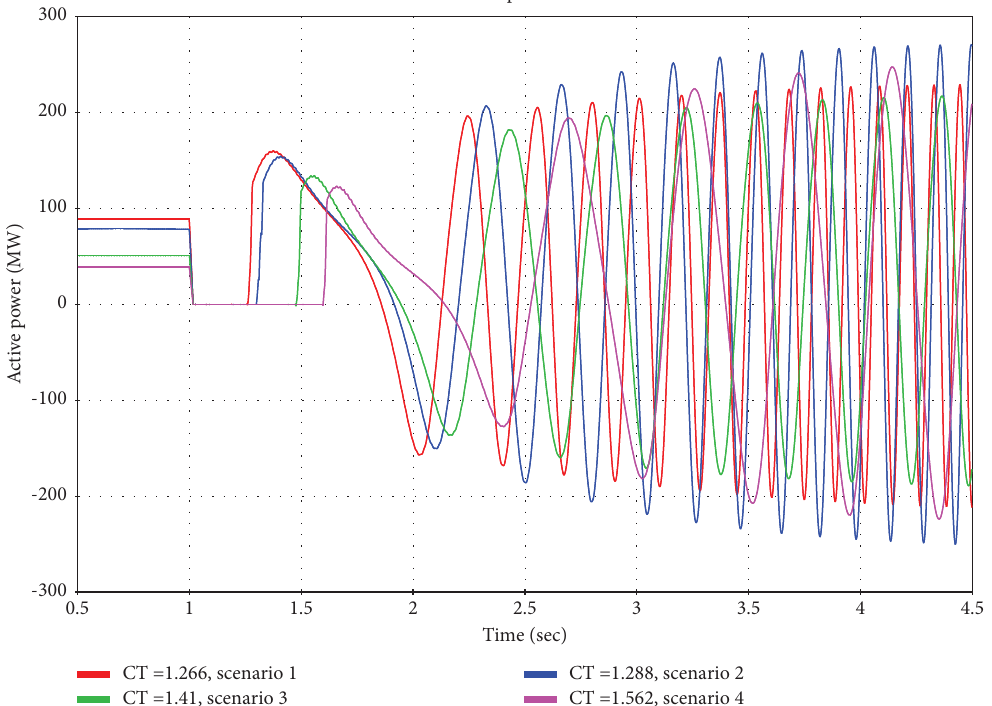
Figure 10: Transmitted power from bus 2 to bus 3 for diferent generated power when CT >